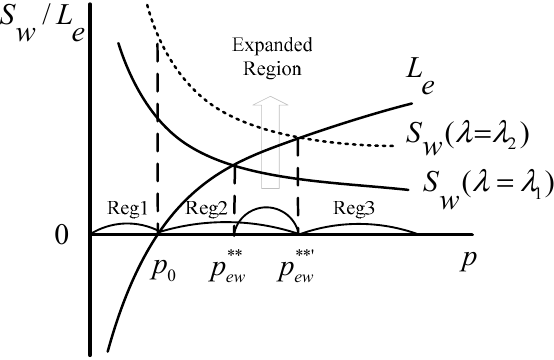
Figure 6. Schematic of the influence of parameter λ on the social welfare ( λ 1 < λ 2 ).